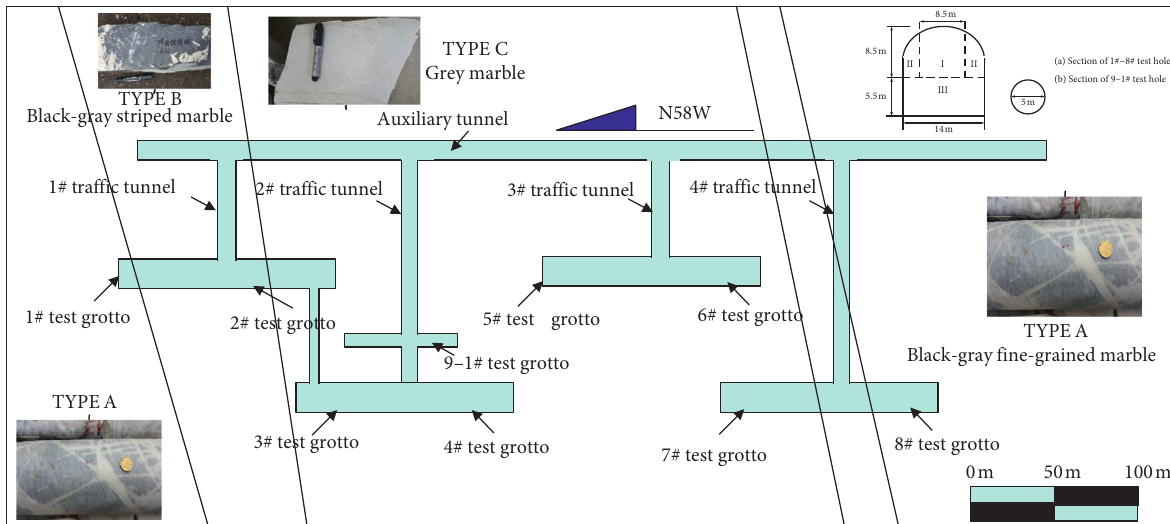
Figure 10: Layout of Jinping deep underground laboratory.